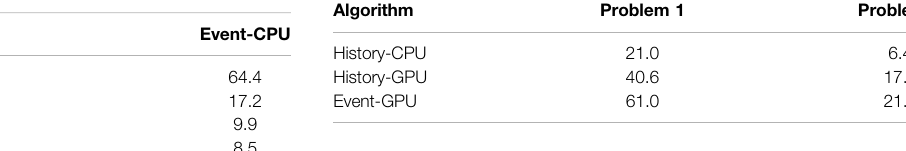
TABLE 6 | Percentage (%) of time spent on different subroutines in the Pincell case, which is simulated using event-based implementation in OpenMC with the continuous-energy scheme.